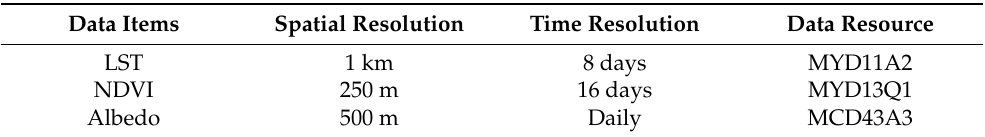
Table 1. MODIS data items and